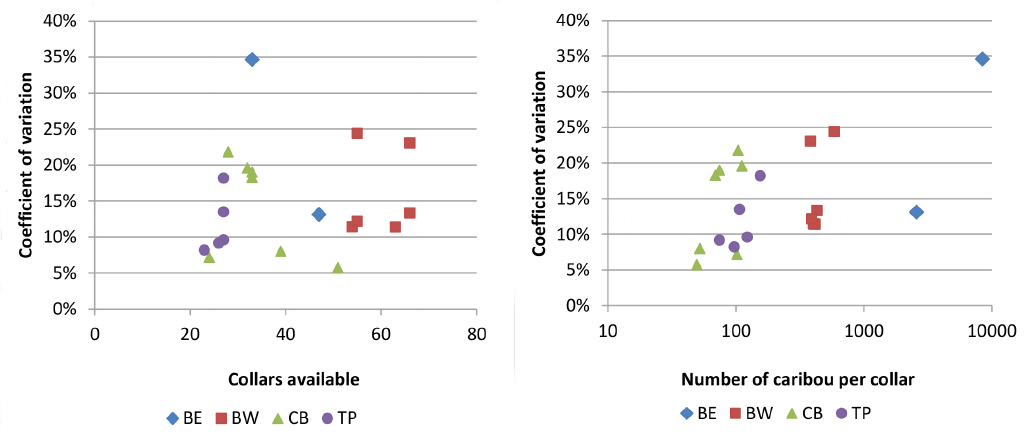
Figure 3. The relationship between the number of caribou collared (left graph) and the number of estimated caribou per collared caribou ( )/No. of collared caribou; right graph) with Rivest estimator precision (CV) for caribou herds in the Northwest Territories and Nunavut, Canada, 2000-2015. Estimates are displayed from the T̂ Bluenose-East (BE), Bluenose-West (BW), Cape Bathurst (CB) and Tuktoyaktuk Peninsula (TP)